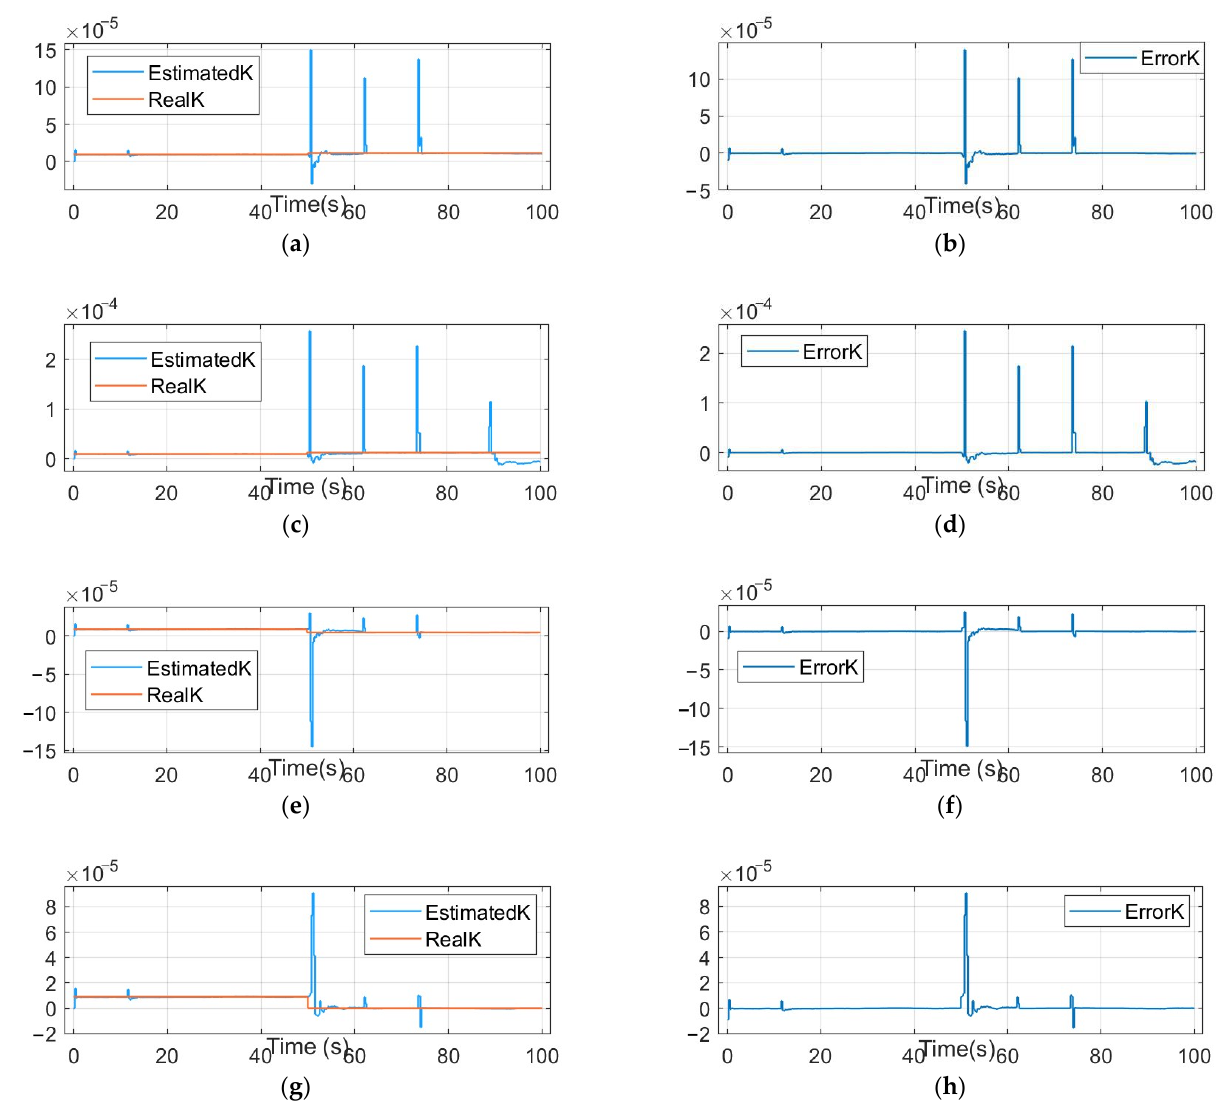
Figure 6. Parameter k identification of the thruster in the fault states: ( a ) parameter k identification of a thruster with an entanglement fault; ( b ) parameter k error of a thruster with an entanglement fault; ( c ) parameter k identification of a thruster with a jamming fault; ( d ) parameter k error of a thruster with a jamming fault; ( e ) parameter k identification of a thruster with a breaking fault; ( f ) parameter k error of a thruster with a breaking fault; ( g ) parameter k identification of a thruster with a falling off fault; ( h ) parameter k error of a thruster with a falling-off fault.